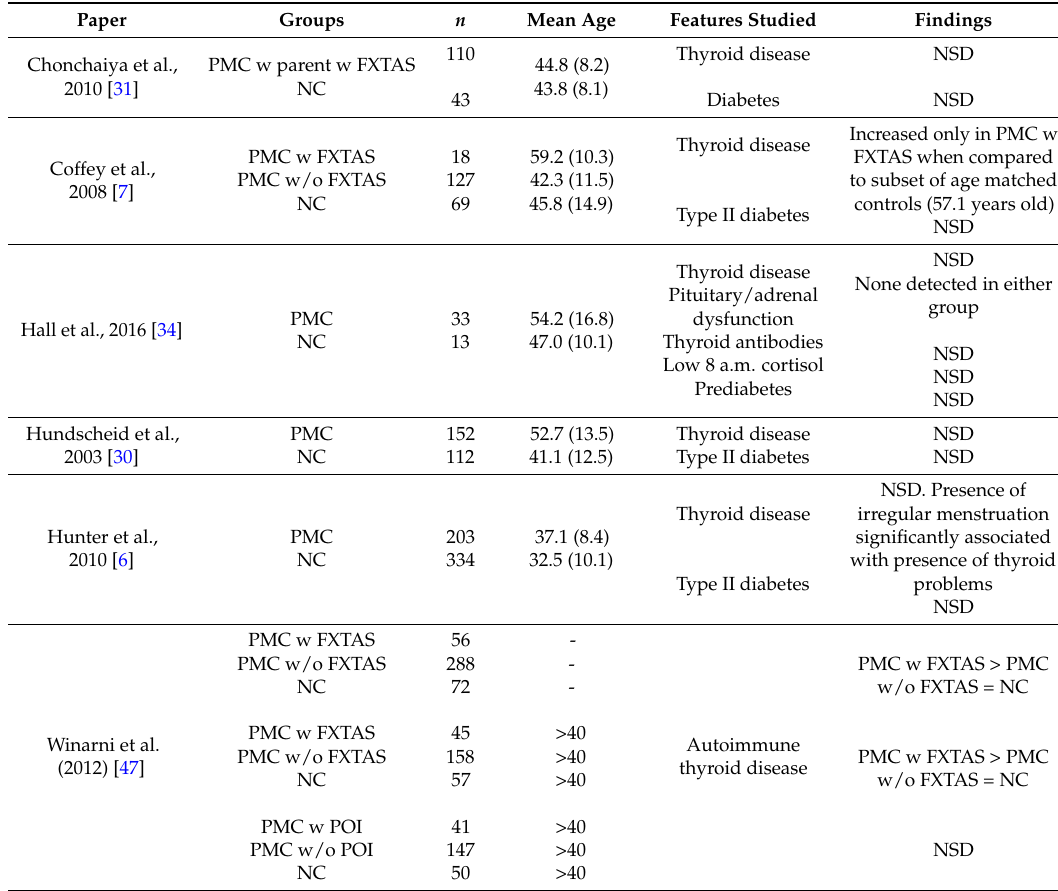
Table 2. Summary of studies considering non-reproductive endocrine issues in